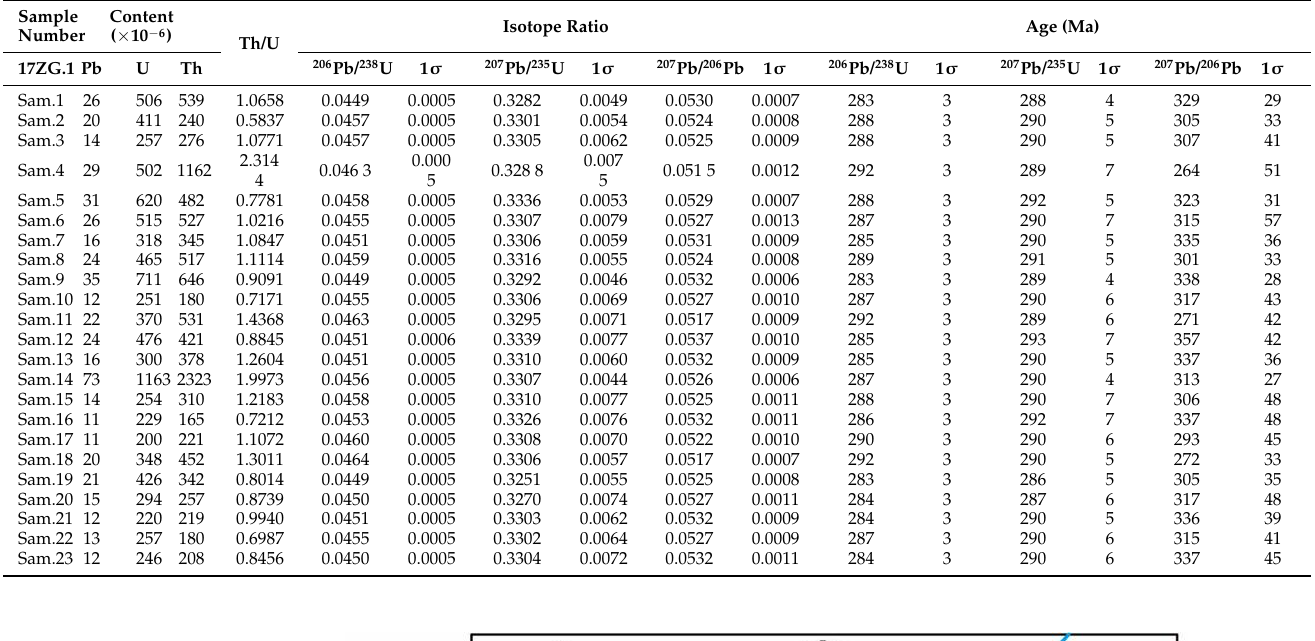
Table 1. Zircon U-Pb dating data from the Zhaojinggou monzogranite, Inner Mongolia.